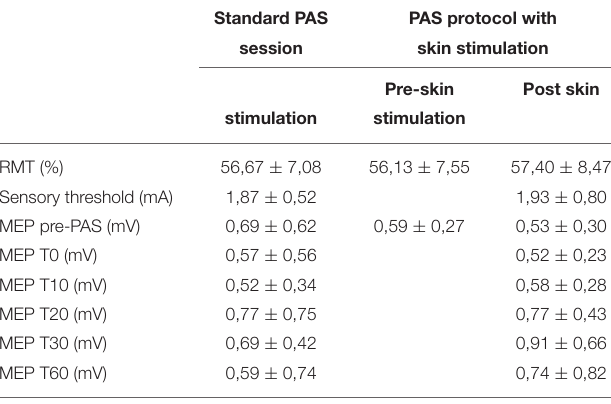
TABLE 1 | Mean RMT, sensory threshold, and the MEP amplitude ± SD in the different time points, both with and without skin stimulation trials. Standard PAS PAS protocol